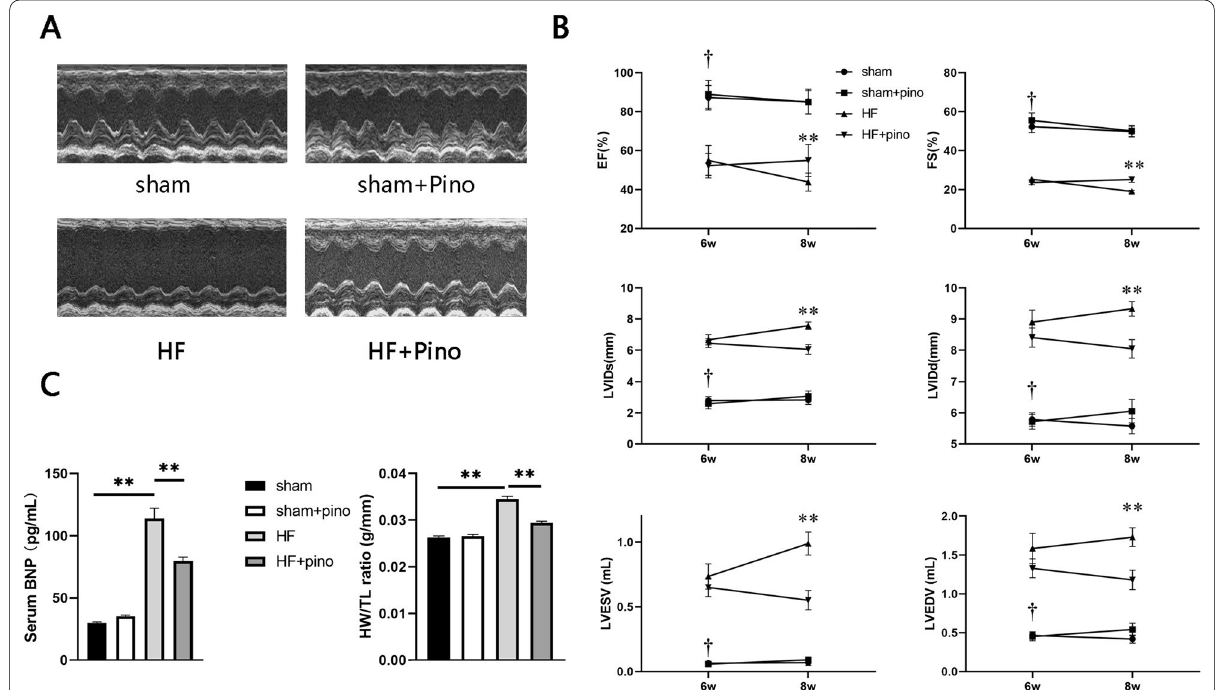
Fig. 2 The effects exerted by chronic application of pinocembrin on cardiac functions. A Representative echocardiogram images in all groups; B the statistic analysis of parameters of cardiac functions; C the serum BNP concentration and heart weight/tibia length which indicated severity of heart failure and hypertrophy of heart, respectively. †: p < 0.01 when sham group compared with HF group; **: p < 0.01 when HF compared with HF group. BNP brain natriuretic peptide, HF heart failure, Pino